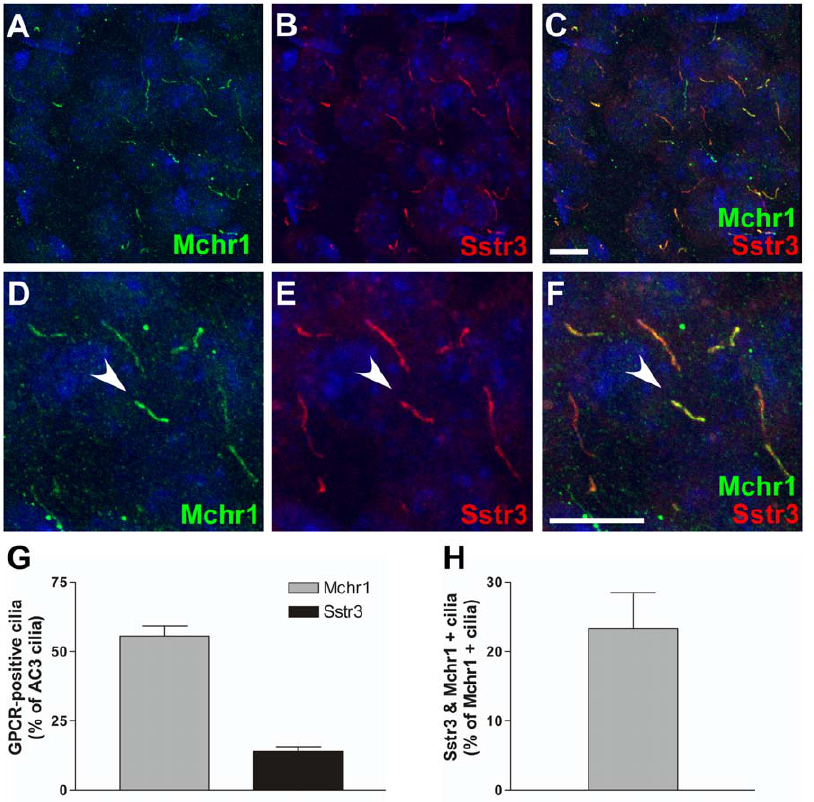
Figure 3. Mchr1 and Sstr3 colocalize in a subset of piriform cortical neuronal cilia. (A–F) Representative image of the piriform cortex from an adult WT mouse colabeled for Mchr1 (green) and Sstr3 (red). Nuclei are stained with DRAQ5 (blue). Labeling for Mchr1 (A) and Sstr3 (B) reveals the presence of Mchr1- and Sstr3-positive cilia in the piriform cortex. Merged image (C) shows colocalization of Mchr1 and Sstr3 on a subset of neuronal cilia. Zoomed in image (D–F) reveals a subset of neuronal cilia that are positive for both Mchr1 and Sstr3 (arrowhead). (G) Quantification of day 7 WT piriform cortical neurons colabeled for Mchr1 and AC3 or Sstr3 and AC3 reveals that Mchr1 localizes to 55.62 6 3.63% (n=186) of AC3-positive cilia and Sstr3 localizes to 14.03 6 1.71% (n=159) of AC3-positive cilia. (H) Graphical representation of the quantification of day 7 WT piriform cortical neurons colabeled for Mchr1 and Sstr3 shows Sstr3 colocalizes to 23.36 6 5.11% (n=86) of Mchr1-positive cilia. Scale bars represent 10 m m.